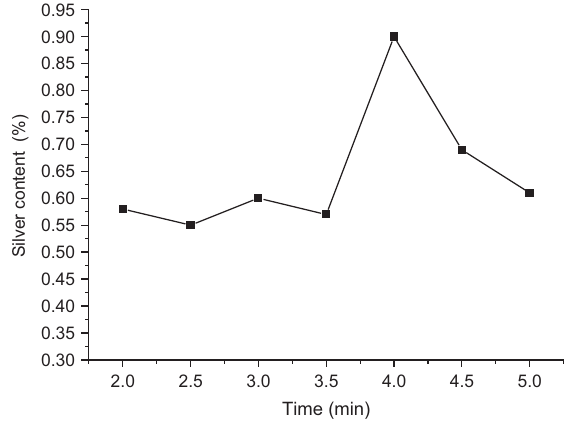
Figure 4 Effect of microwave power on the silver content of Ag-MMT. AgNO concentration = 0.2 m , microwave time = 4 3